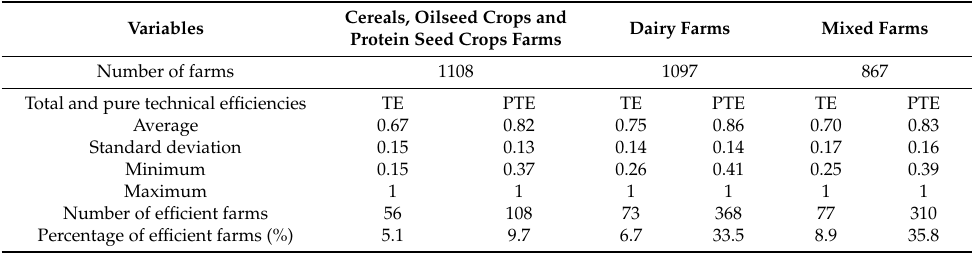
Table 6. Total technical efficiency (TE) and pure technical efficiency (PTE) of the three types of farms calculated under technology